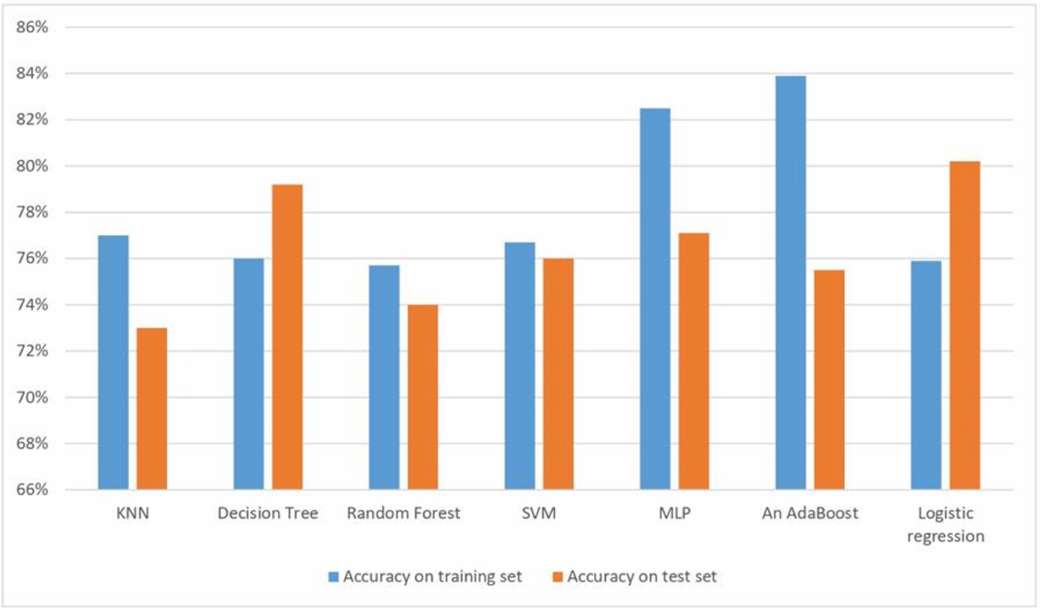
Figure 9. The classification algorithms accuracy using 80% training and 20% testing